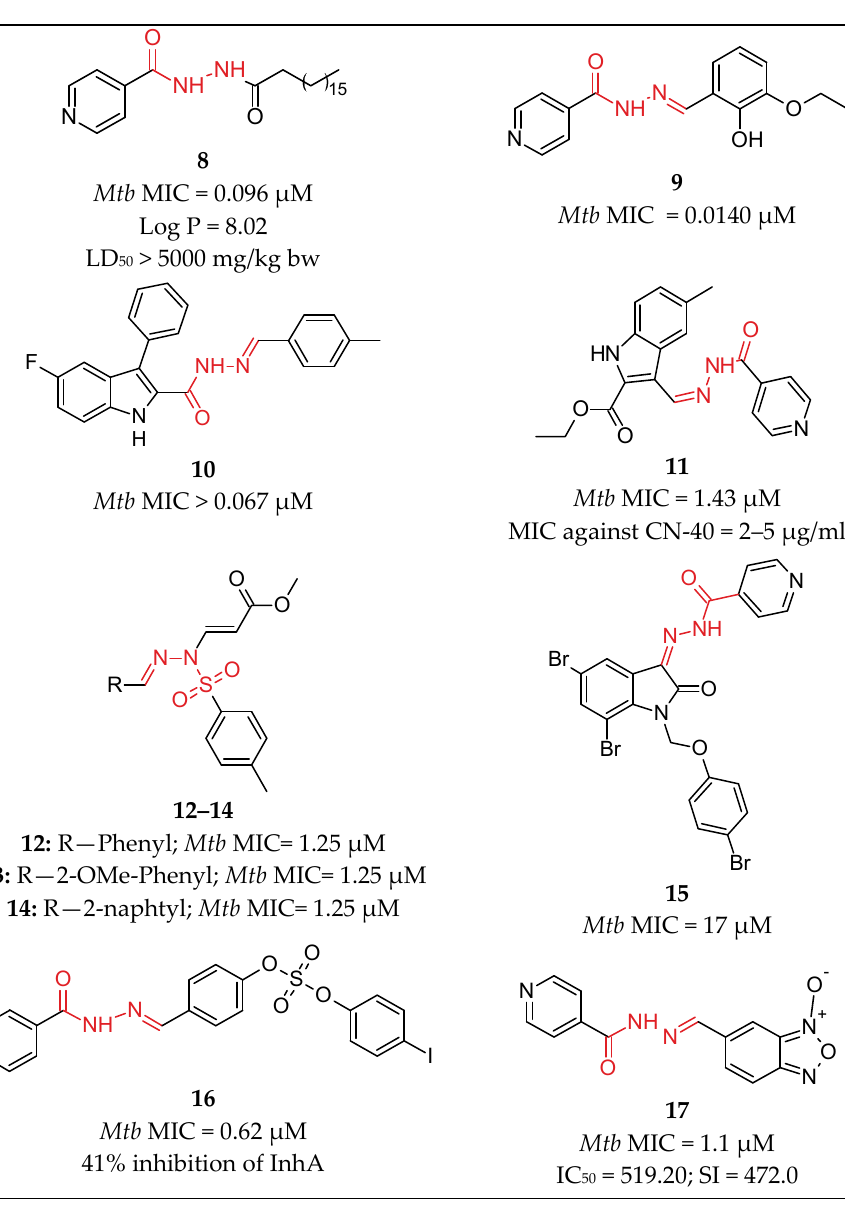
Figure 6. Chemical structures of compounds 8 [34], 9 [35], 10 [36], 11 [37], 12 – 14 [38], 15 [39], 16 [40] and 17 [41].